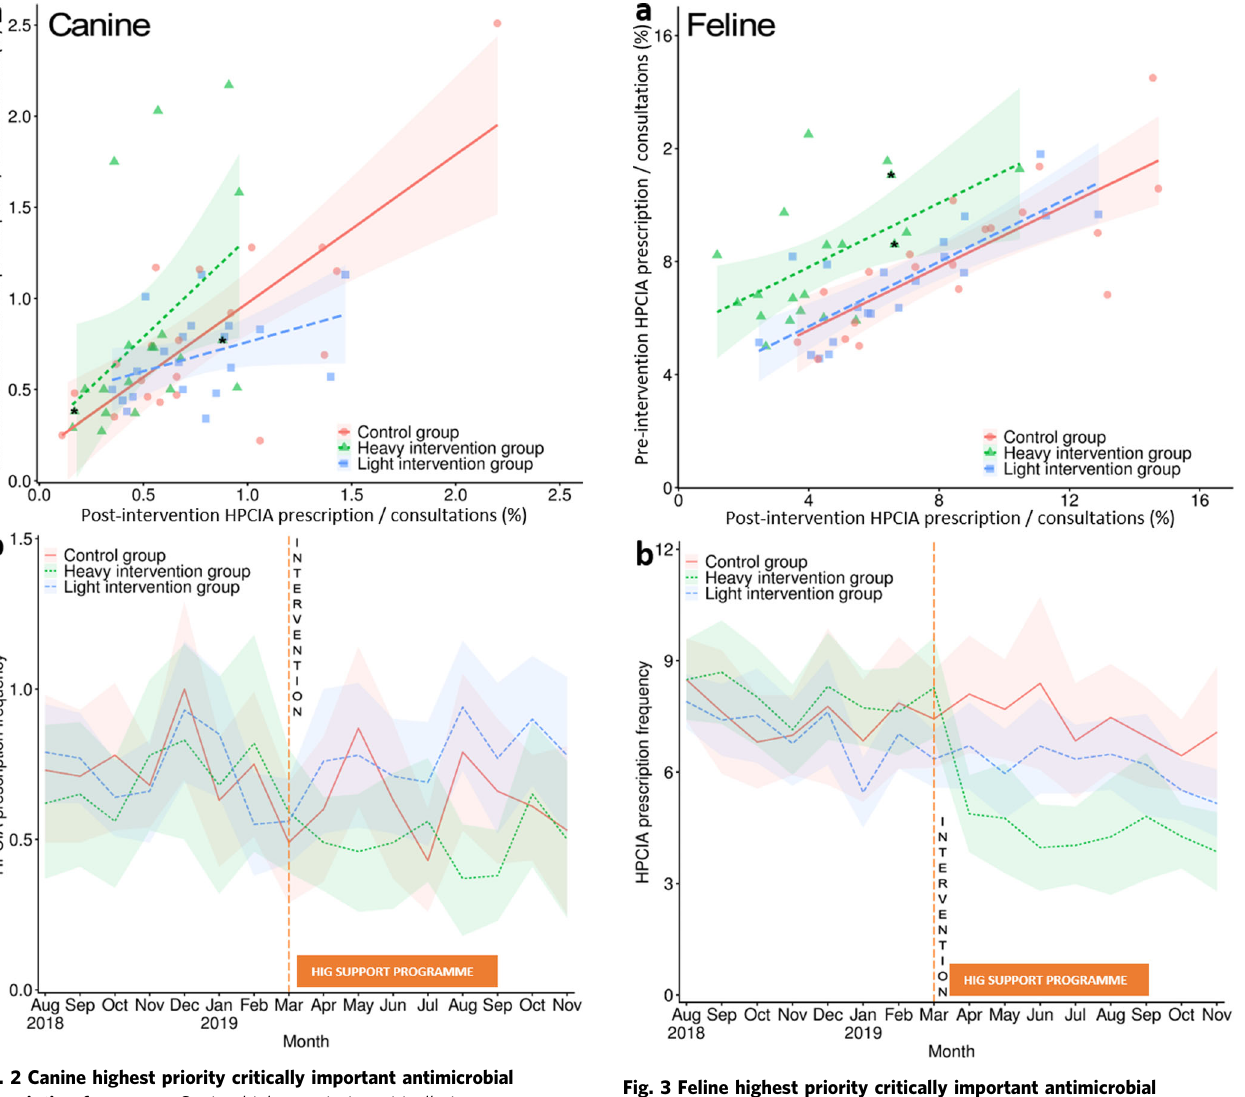
Fig. 3 Feline highest priority critically important antimicrobial prescription frequency. Feline highest priority critically important antimicrobial (HPCIA) prescription frequency as a percentage of total consultations, measured by ( a ) practice pre-intervention (August 2018 – March 2019 inclusive) and post-intervention (April – November 2019 inclusive), and ( b ) month. Lines in plot a refer to linear regression fi ts, modelling intervention status by practice, with lines referring to regression fi t estimates around a 95% con fi dence interval (shaded region). An asterisk refers to practices in the HIG which declined to participate in the post- benchmarking intervention re fl ection and education programme. Lines in plot b refer to HPCIA prescription frequency as a percentage of total consultations; the red solid line in both plots a and b refers to fi ndings from the control group; the blue hashed line refers to the light intervention group, and the green dotted line refers to the heavy intervention group (HIG). The orange dashed line in panel b shows the month at which the initial noti fi cation took place, and the orange solid box outlines the months in which the HIG could access further support if requested. Shaded regions refer to 95% con fi dence intervals. Data is derived from 33,613 pre- intervention and 30,632 post-intervention CG consultations; 39,803 pre- intervention and 37,339 post-intervention LIG consultations, and 25,661 pre-intervention and 25,808 post-intervention HIG